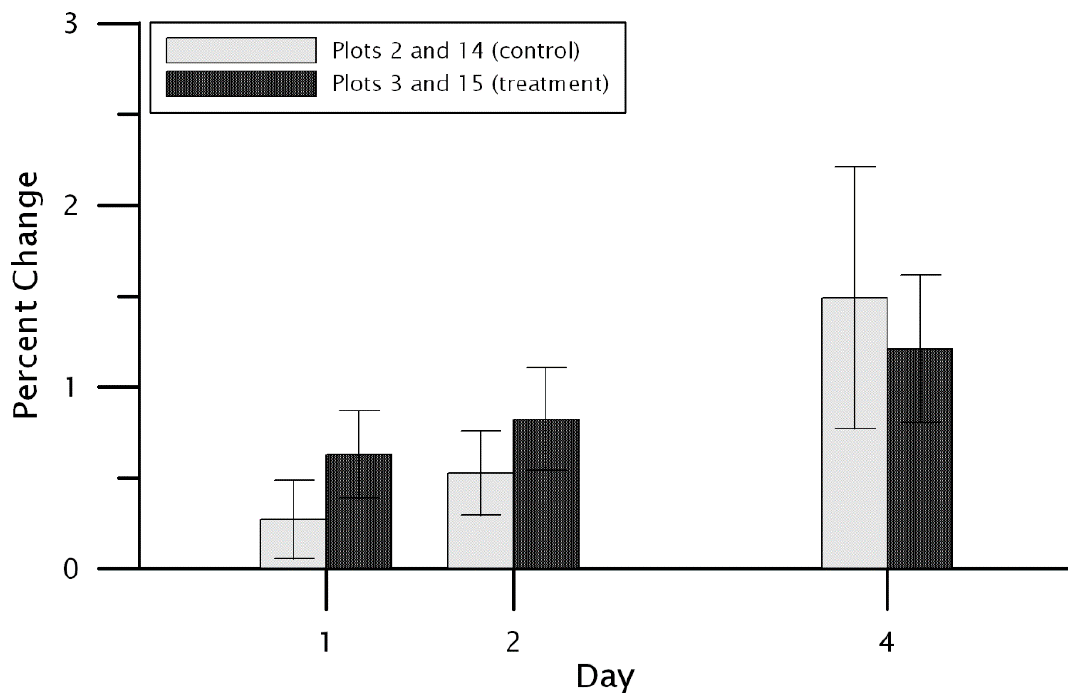
Figure 4. The mean drying rate for the 5 cm depth at the control plots (Plot 2 and Plot 14) and the treatment plots (Plot 3 and Plot 15). The drying rate is shown for 1, 2, and 4 days following precipi- tation events. Error bars indicate 95 percent confidence limits on the mean.